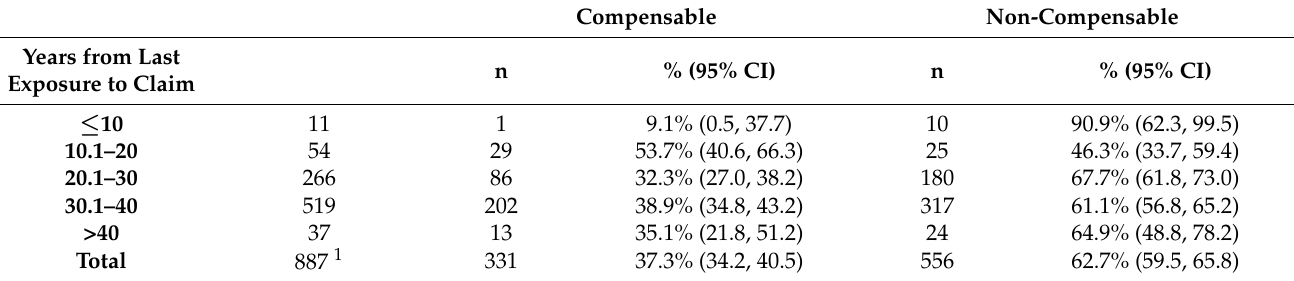
Table 4. Claim outcome of workers with <10 years of service, stratified by years since last